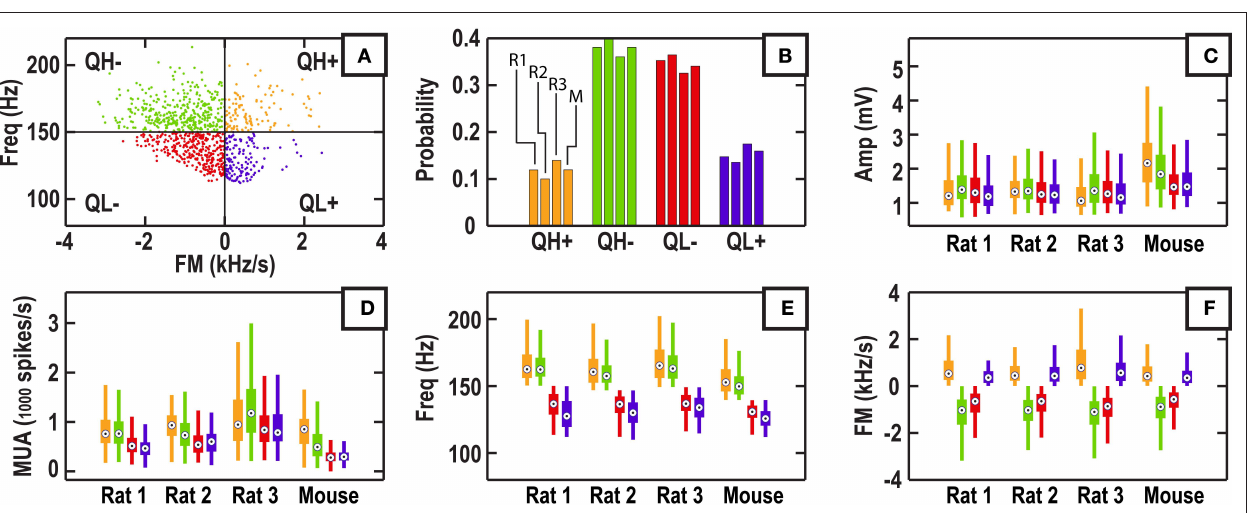
FIGURE 5 | Partitioning of ripple events based on frequency information alone. (A) The boundaries for partitioning are drawn at 150 Hz and 0 kHz/s. QH + represents high frequency and positive FM, QH − represents high frequency and negative FM, QL − represents low frequency and negative FM, QL + represents